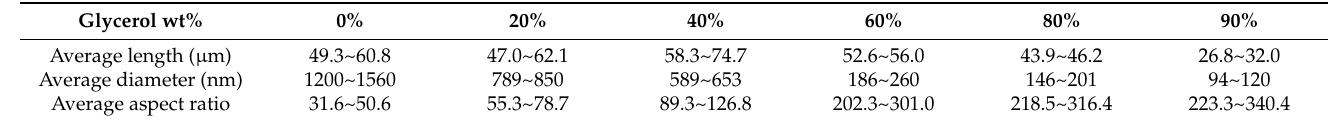
Table 5. The size of generated whiskers in different glycerol